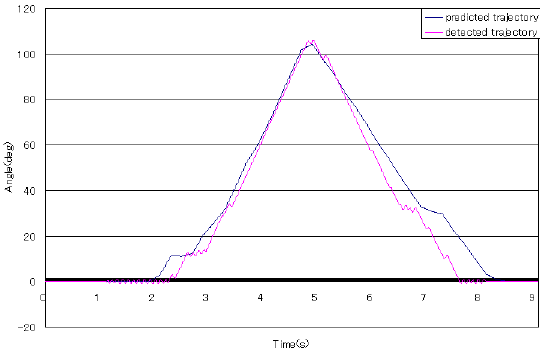
Figure 19. The typical elbow flexion and extension for S1.